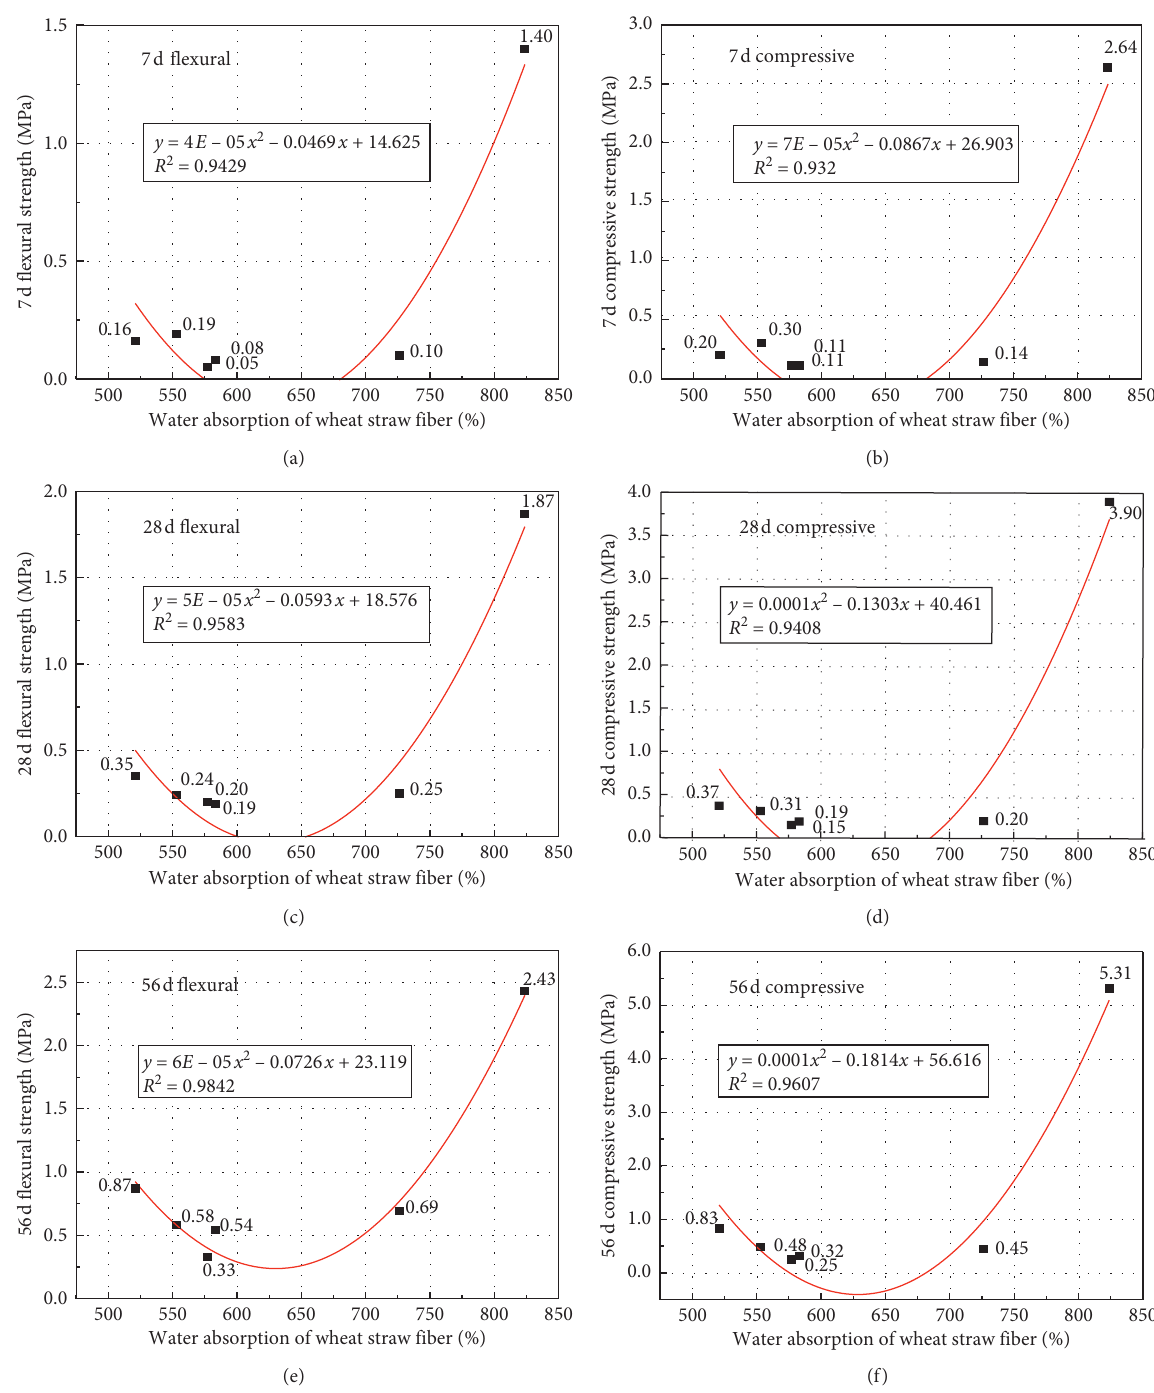
Figure 10: Fitting curves of water absorption of wheat straw fiber versus strength of WSFCC